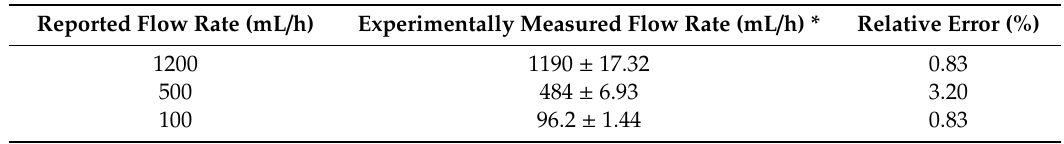
Table 6. Experimental values of flow rate compared with the reported values by the infusion pump display.